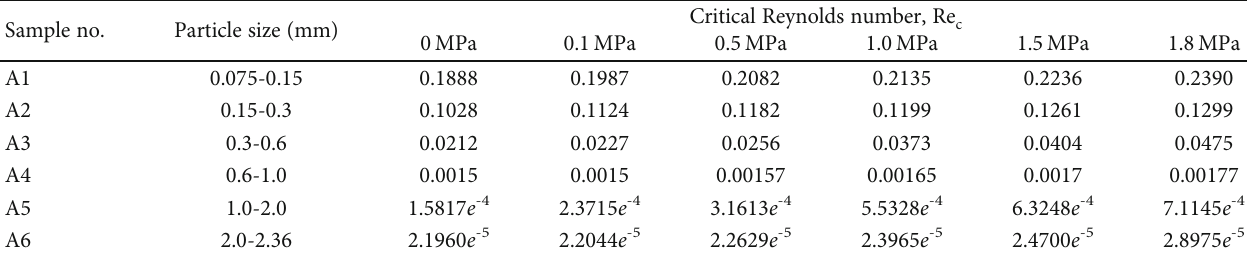
Table 2: Critical Reynolds number of Aeolian sand and river sand particles under various axial stress. Sample